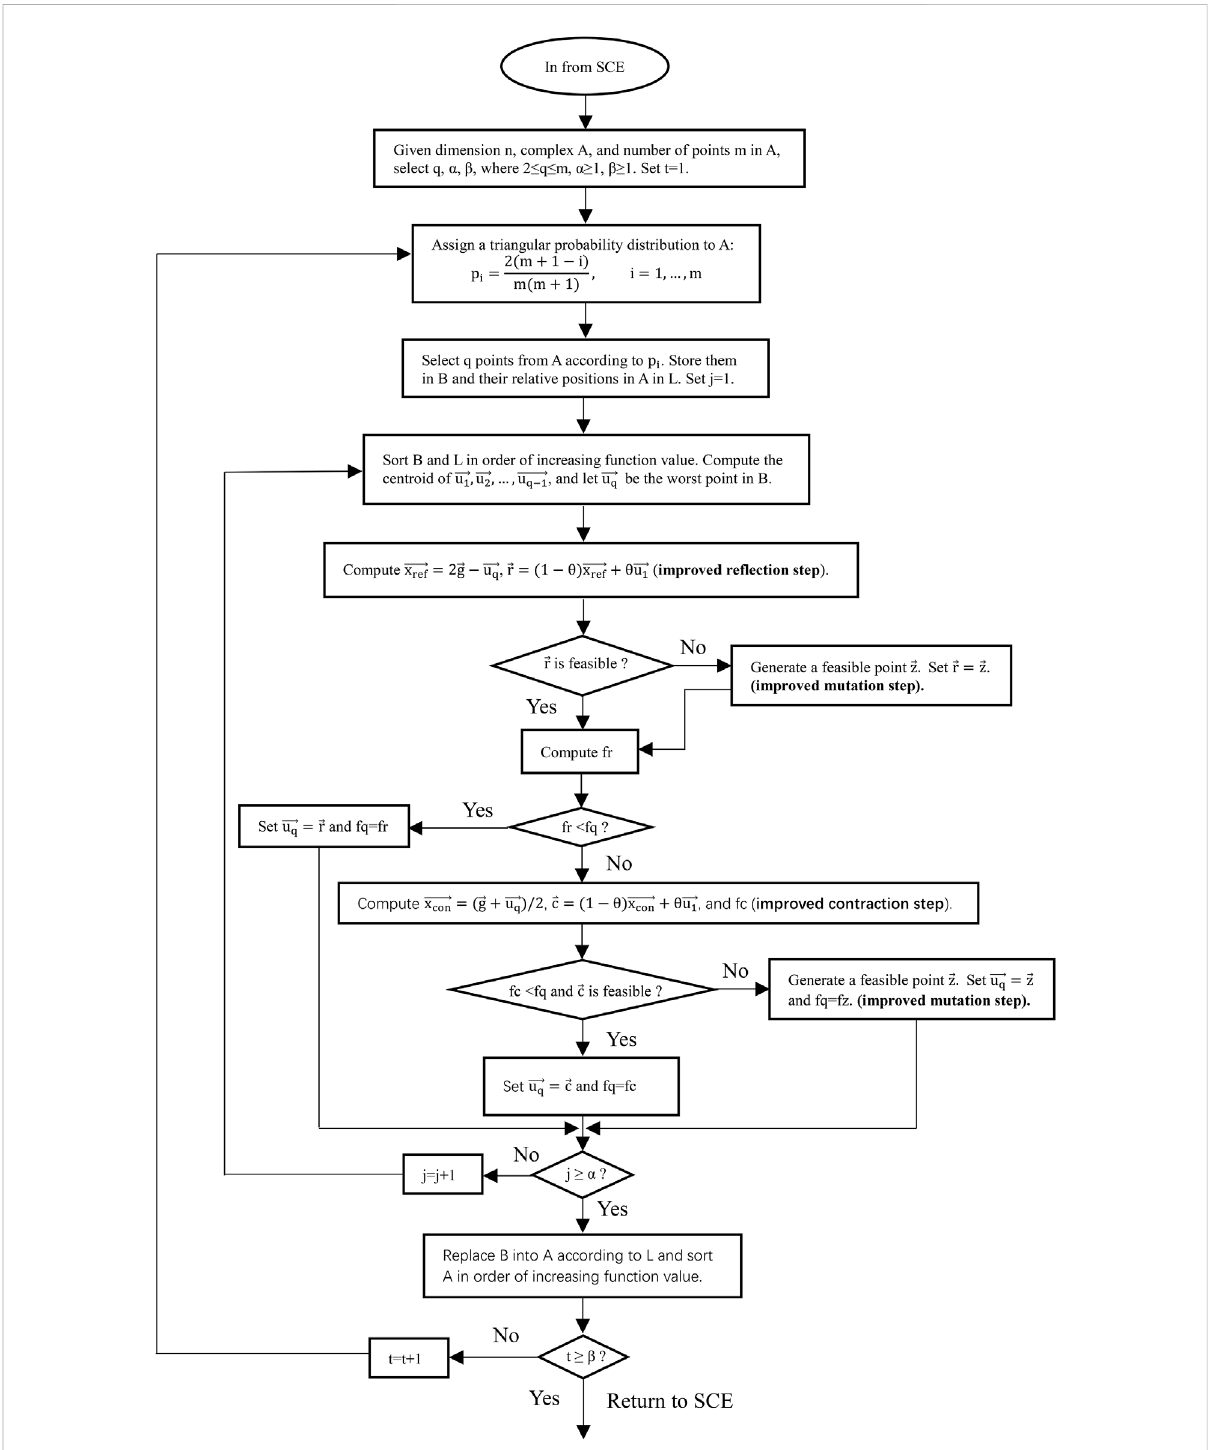
FIGURE 3 Flow chart of the improved CCE